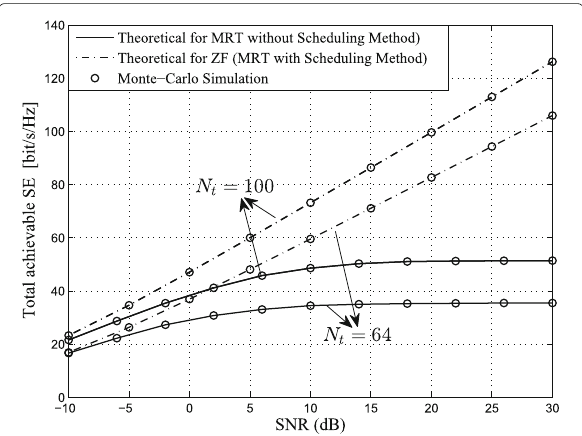
Fig. 5 The total achievable ergodic SE versus the number of BS antennas for SNR = 5 and 10 dB